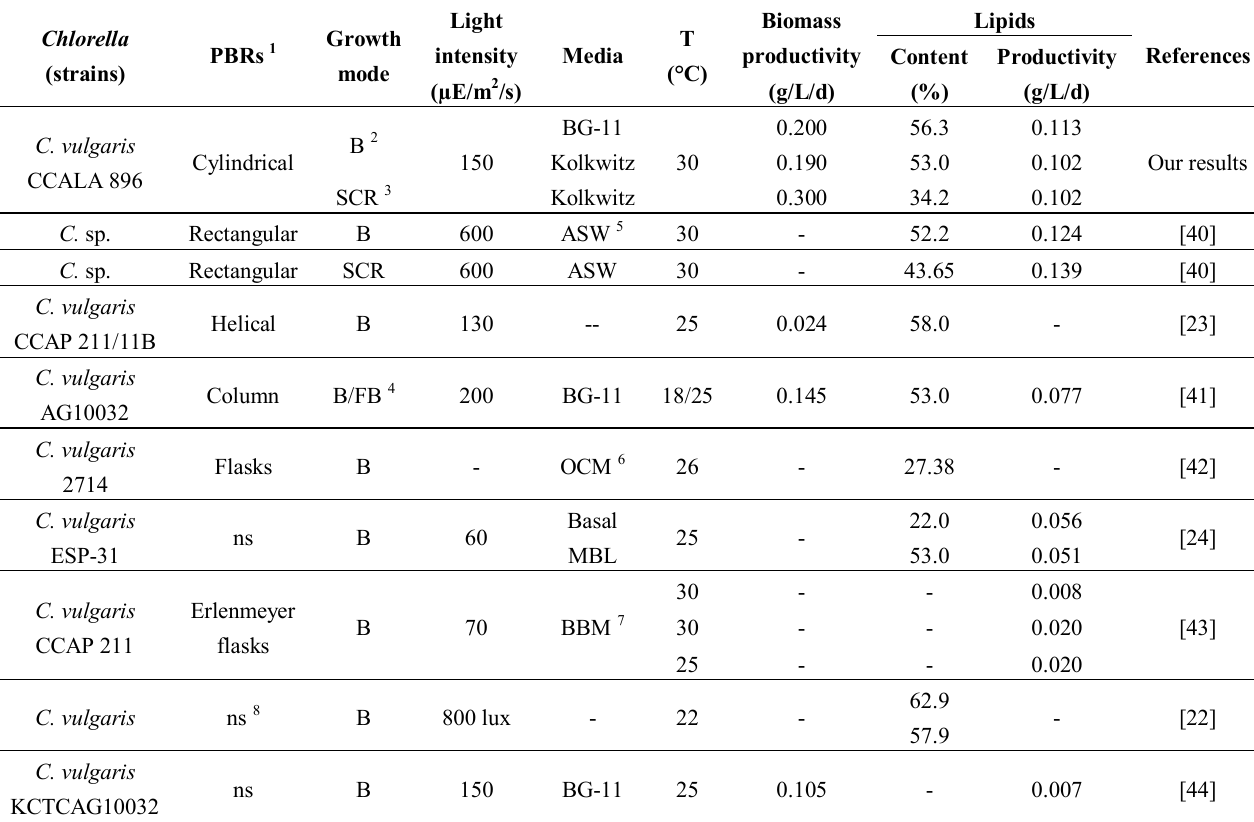
Table 5. Comparison of our results with some other Chlorella strains found in the